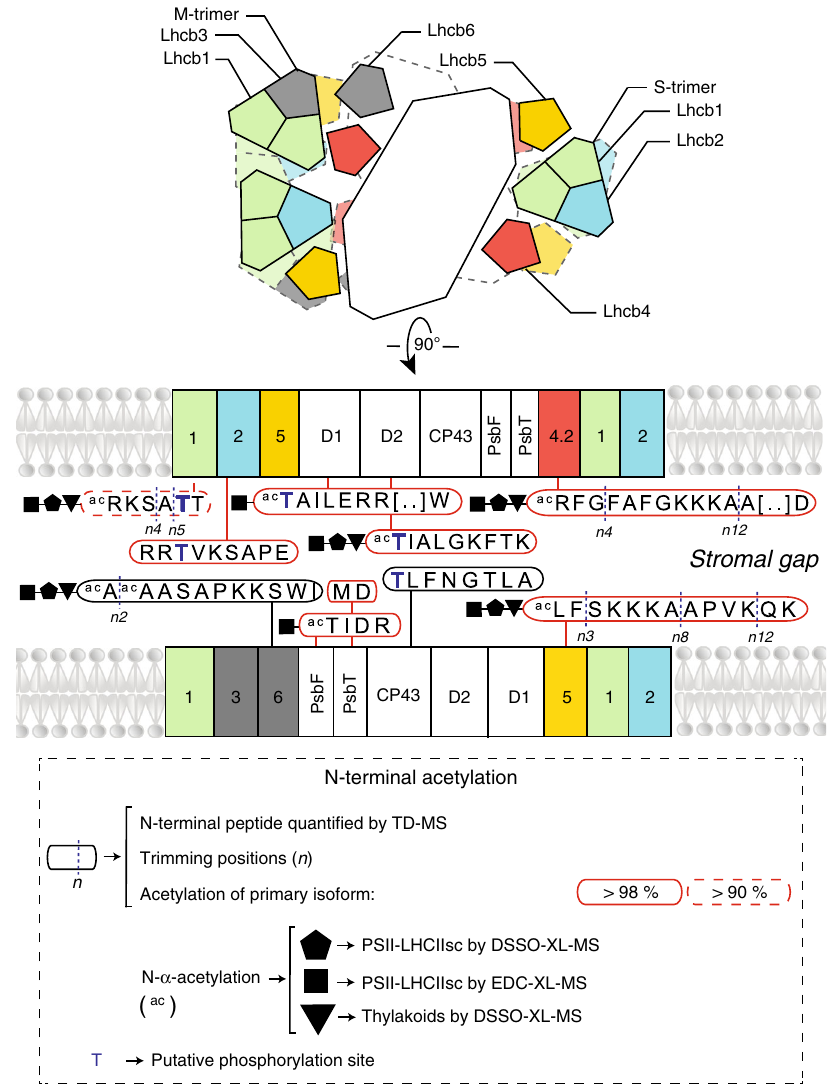
Fig. 6 Map of acetylated N-terminal domains of PSII – LHCIIsc subunits spanning the stromal gap. Schematic top- and side-view of the (C 2 S 2 M)×2, highlighting the acetylated N-terminal domains of the proteins spanning across the stromal gap detected and quanti fi ed by TD-MS (red box indicates acetylation rate of the complete primary isoform in any light condition, above 98% solid line; above 90% dashed line). Trimming position(s) and putative phosphorylation sites (based on homologous phosphosites previously detected in other plants 29 ) are indicated. N- α -acetylation (ac) detected in crosslinked peptides is shown. N- α -acetylation detected by XL-MS in vitro on isolated PSII – LHCIIsc (treated with DSSO, pentagon; treated with EDC, square) and in situ on the thylakoid membranes (treated with DSSO; triangle) is